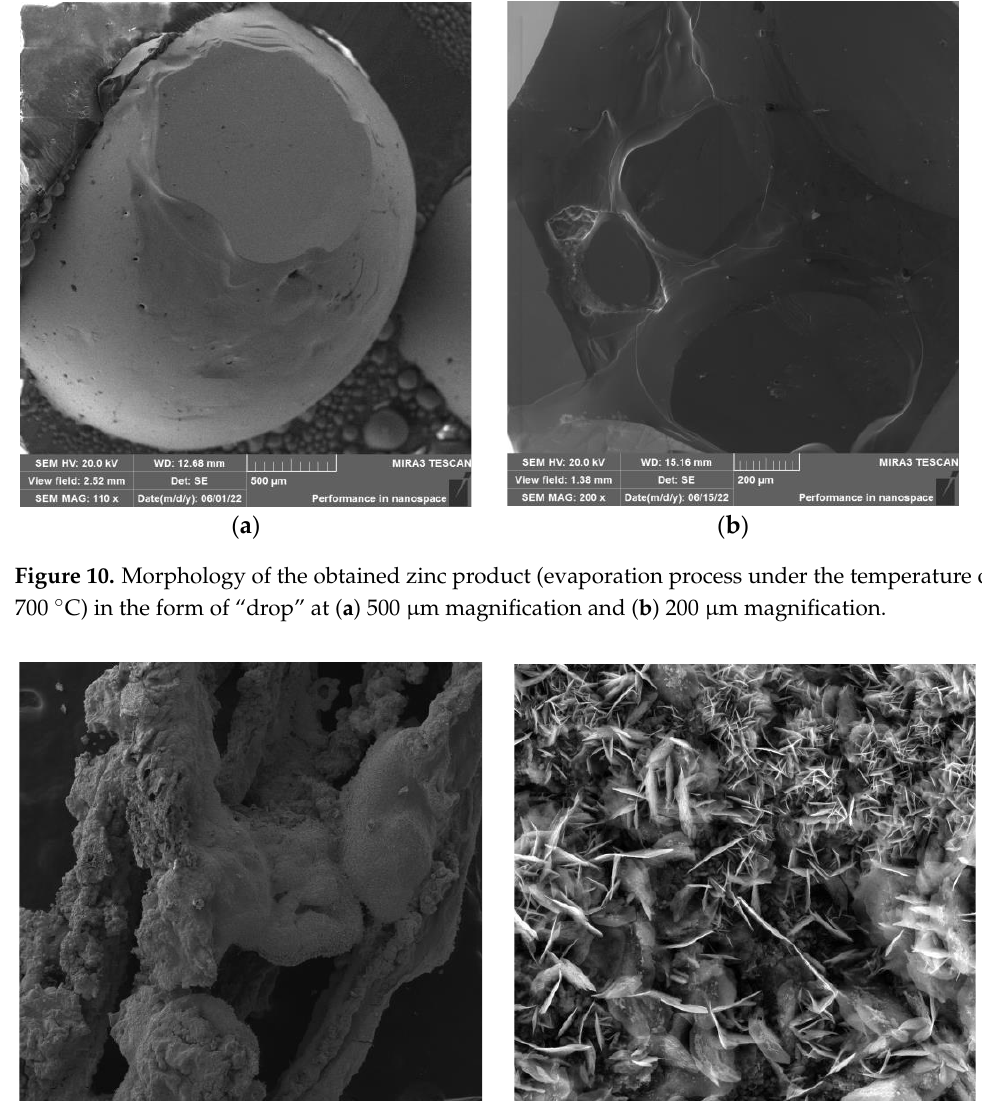
Figure 9. Morphology of the obtained zinc product (evaporation process under the temperature of 700 °C) in form of “foil” at ( a ) 1 mm magnification and ( b ) 100 µm magnification. Results of SEM analysis of the product in the form of “foil” is shown in Figure 9a,b. The morphology of this product is smooth and consistent.